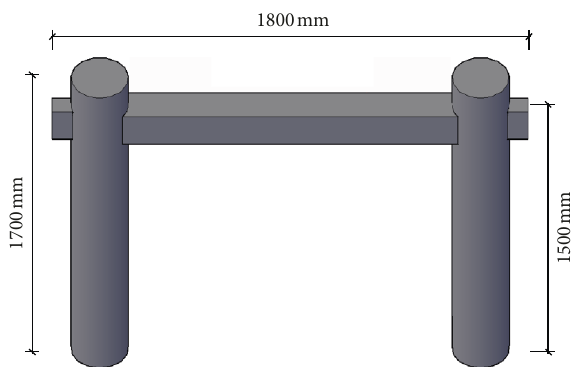
Figure 1: Straight-tenon wood frame model. Table 1: Original dimensions of components and model dimensions.